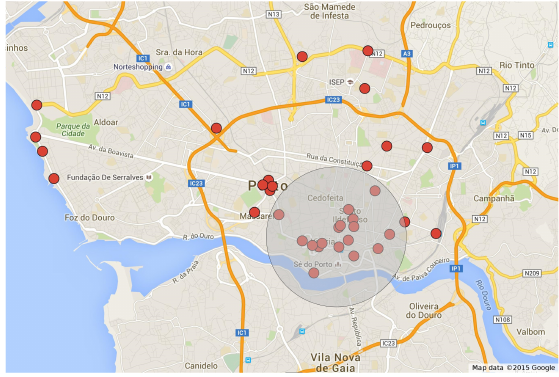
Figure 7. City center